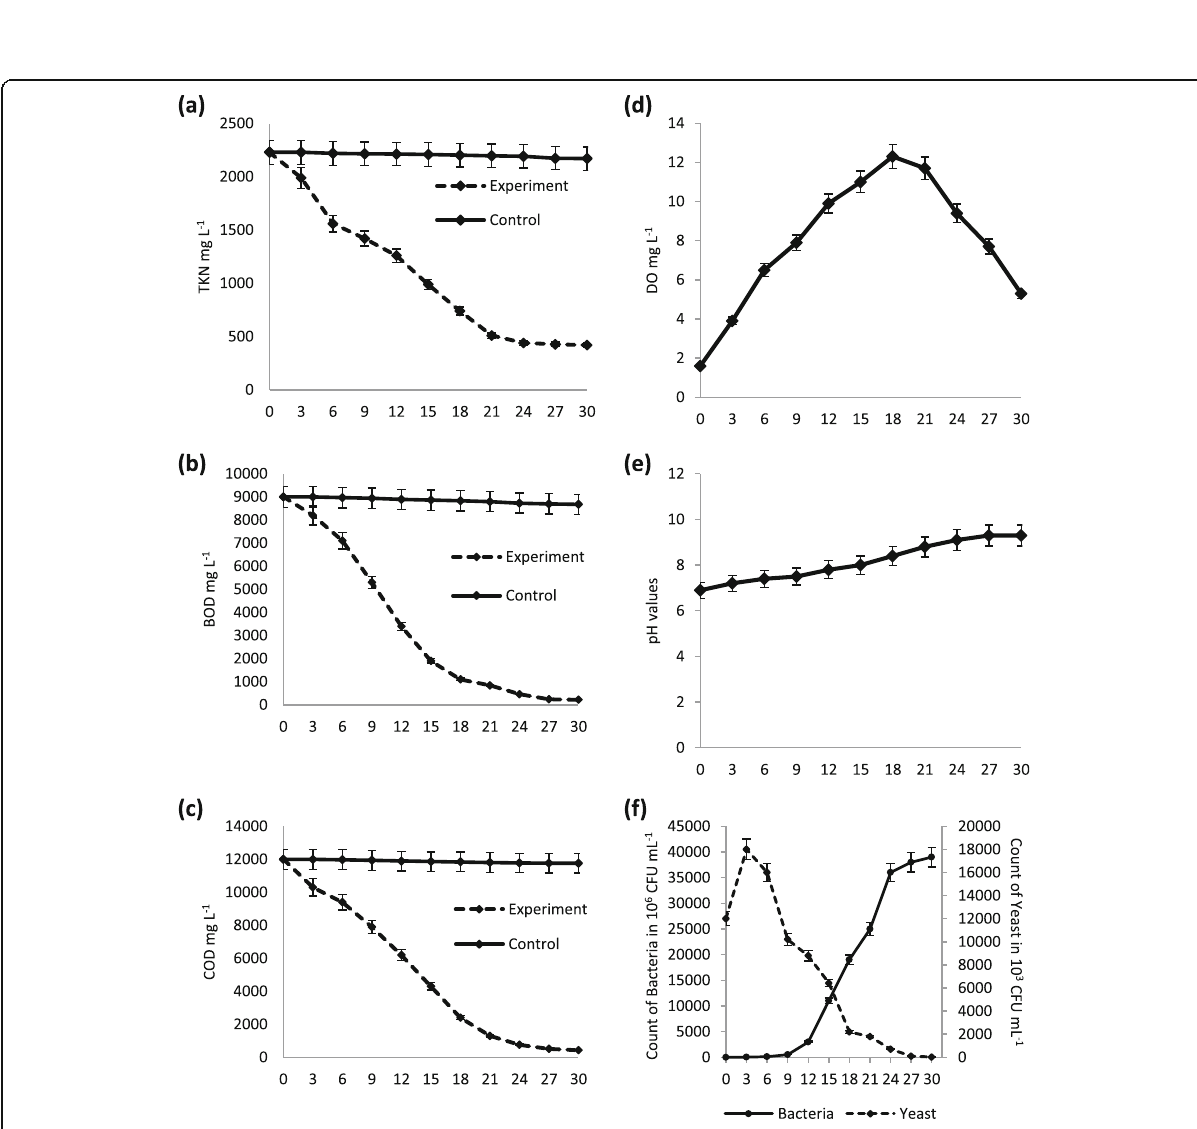
Fig. 2 Illustrations concerning bio-treatment of maize processing wastewater by indigenous bacteria ( a ) reduction in TKN ( b ) reduction in COD ( c ) reduction in BOD ( d ) DO concentrations during the experiment ( e ) elevation in pH values ( f ) growth rates of bacteria and yeast during the experiment